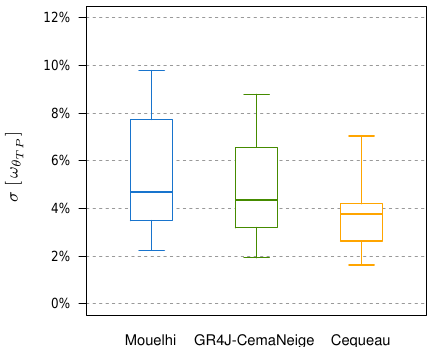
Fig. 6. Standard deviations of the 10yr mean flow volume errors ob- tained during calibration over the full record (distribution for each model over 20